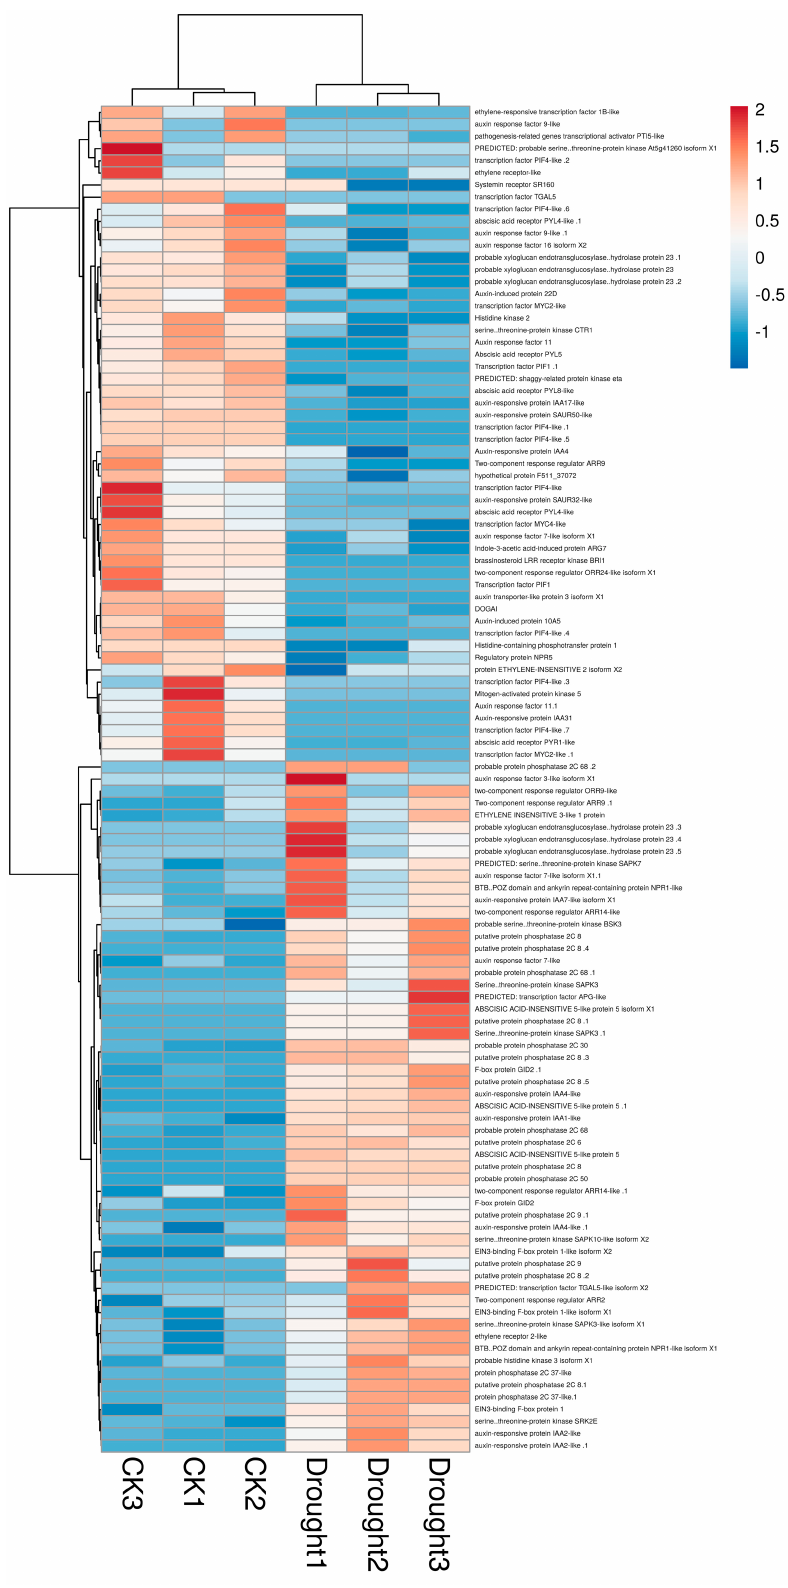
Figure 6. Hierarchical clustering analysis of DEGs involved in plant hormone signal transduction (ko04075) in B. striata under CK and drought conditions. Each group has three replicates.